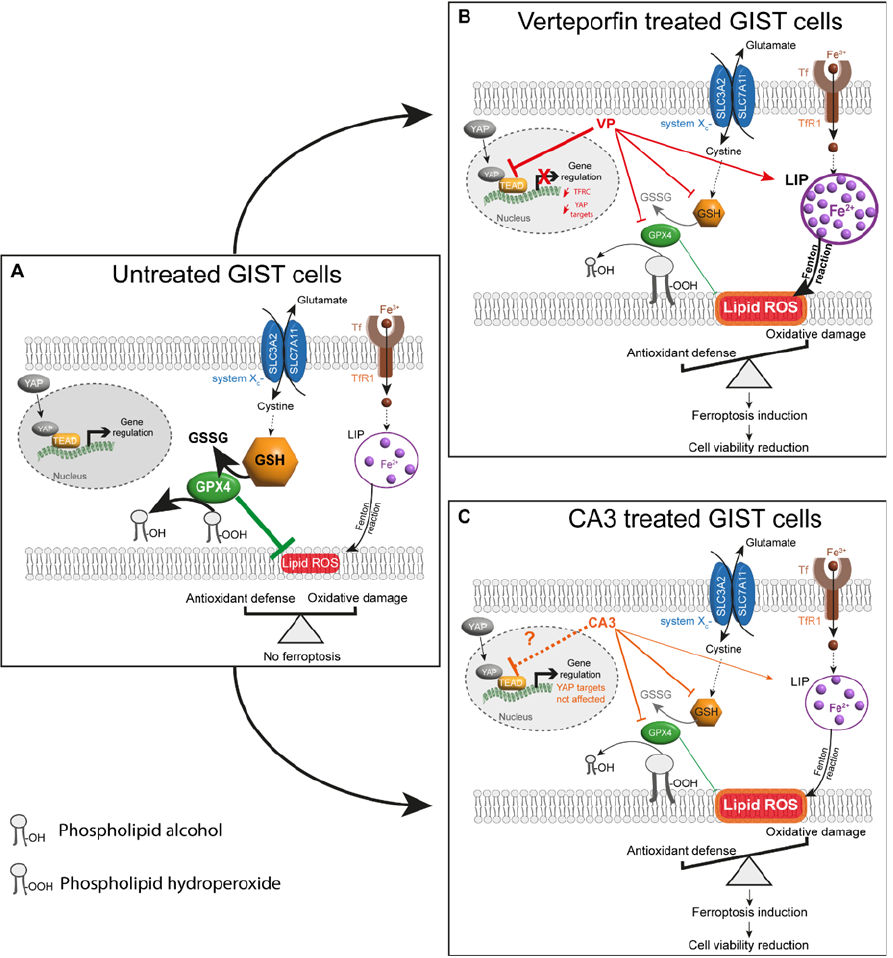
Figure 11. Proposed model for ferroptosis induction by VP or CA3 in GIST human cell lines. ( A ) In untreated GIST cells, a balance between oxidative damage through lipid ROS/lipid peroxidation and antioxidant defenses, including the SLC7A11/GSH/GPX4 axis, prevents ferroptosis. Furthermore, YAP can interact with TEAD and regulate gene expression. ( B ) GIST882 and GIST48 treatment with VP induced an increase in LIP, composed mainly of ferrous iron, and a significant reduction in the GSH content and GPX4 protein level, which are responsible for increasing the lipid peroxidation. As a result of an impaired balance between oxidative damage and antioxidant defenses, ferroptosis induction mediated a reduction in cell viability. The effect of VP on ferroptosis might be due to YAP inhibition, as YAP target genes were downregulated. Additionally, TFRC gene expression was reduced, probably in response to the elevated free ferrous iron. ( C ) In CA3-treated cells, the free ferrous iron concentration difference was not statistically significant in GIST48, and no modification was observed in GIST882. However, the GSH content and GPX4 protein level were significantly reduced, which may be responsible for an increase in the lipid peroxidation. As a result of an impaired balance between oxidative damage and antioxidant defenses, ferroptosis induction mediated a cell viability reduction. However, in GIST882 and GIST48 cells, the CA3 effect on ferroptosis induction might be independent of an inhibition of the YAP transcriptional program. Thick arrows indicate a stronger effect of the drug. Thin arrows indicate a lesser effect of the drug. Red and orange arrows indicate the different effects mediated by VP and CA3, respectively. The dashed black arrow indicates that intermediate steps are hidden. The dashed orange arrow indicates that, in contrast to the literature, our original results show that CA3 does not inhibit the YAP transcriptional program in GIST882 and GIST48 cell lines. GSH: glutathione; GSSG: glutathione disulfide; LIP: labile iron pool; Tf: transferrin; TFRC: transferrin receptor 1; Fe 2+ : ferrous iron; Fe 3+ : ferric